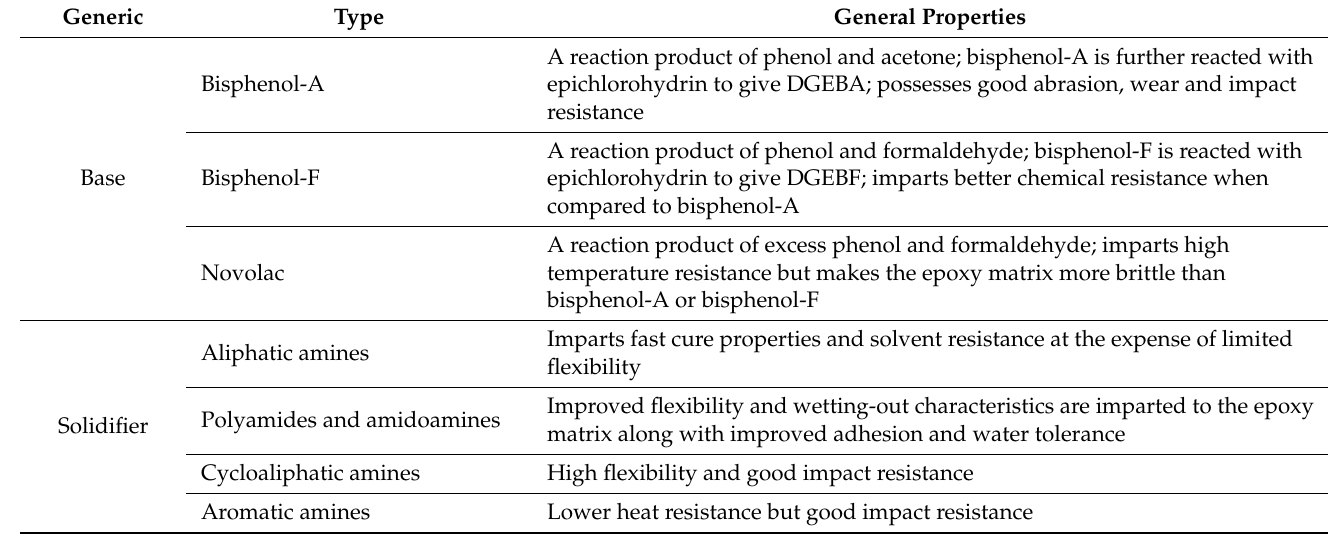
Table 2. Properties of base and solidifier components used in epoxy formulation